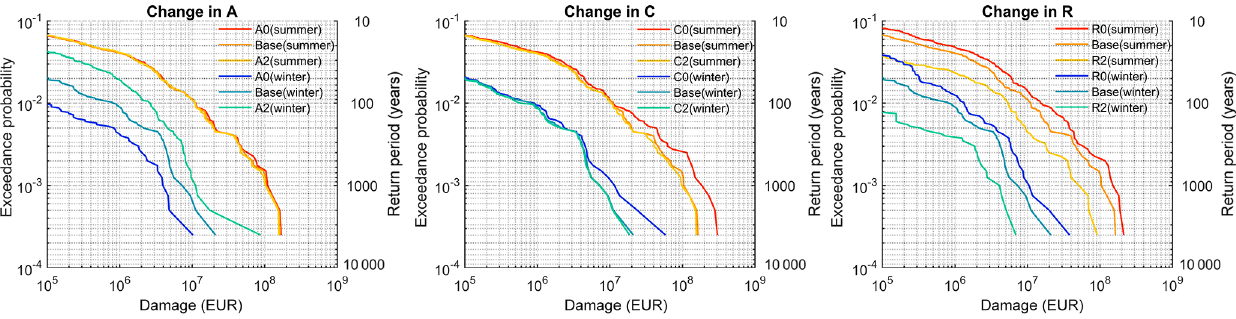
Figure 8. Risk curves for changes in three components, atmosphere (A), catchment system (C), and river system (R), under the baseline conditions for winter (blue colours) and summer (red